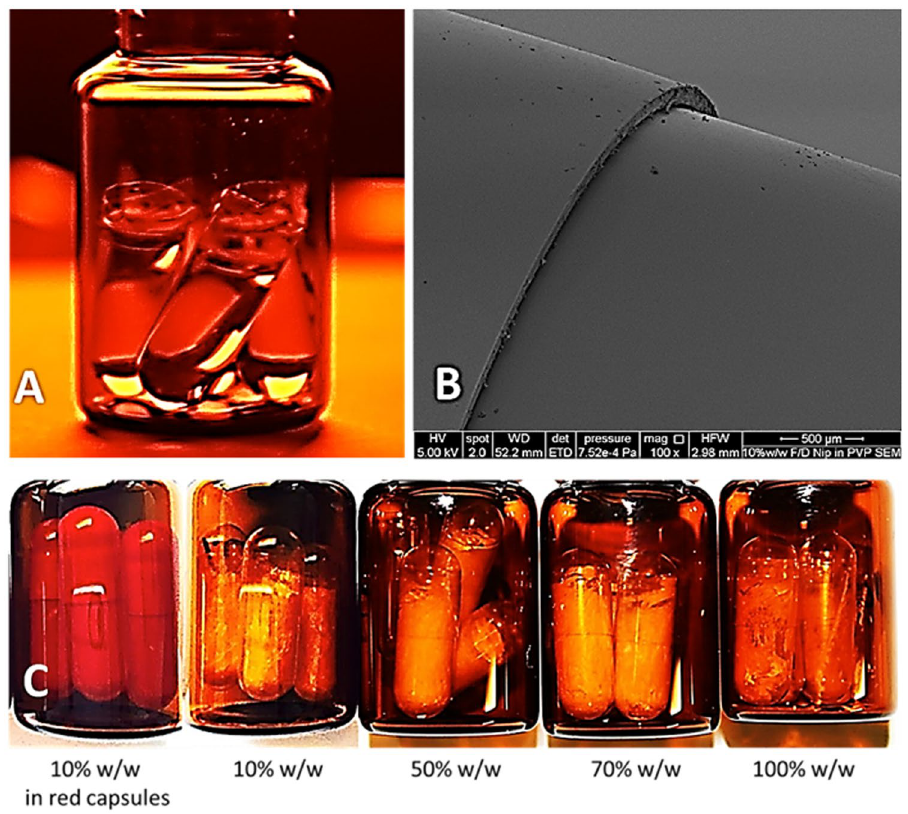
Figure 2. ( A ) Clear gelatin capsules filled with 0.5 mL of liquid TBA (40 ± 0.5 °C). ( B ) SEM of in-situ red capsule freeze-dried formulation. The capsule bottom part was involved in the freeze-drying process, while the top part (left of the image) was not. The structure of both looks identical under SEM. ( C ) In-situ capsule freeze- dried samples of nifedpine in PVP. Left to right showing low to high w/w % of NIF in PVP. All formulations were designed to contain 10 mg of nifedipine whatever the amount of PVP